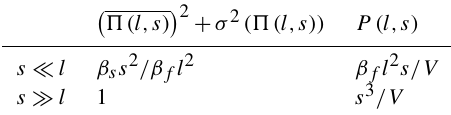
Table 1. Scaling of parameters (cid:0) (cid:53)(l,s) (cid:1) P(l,s)